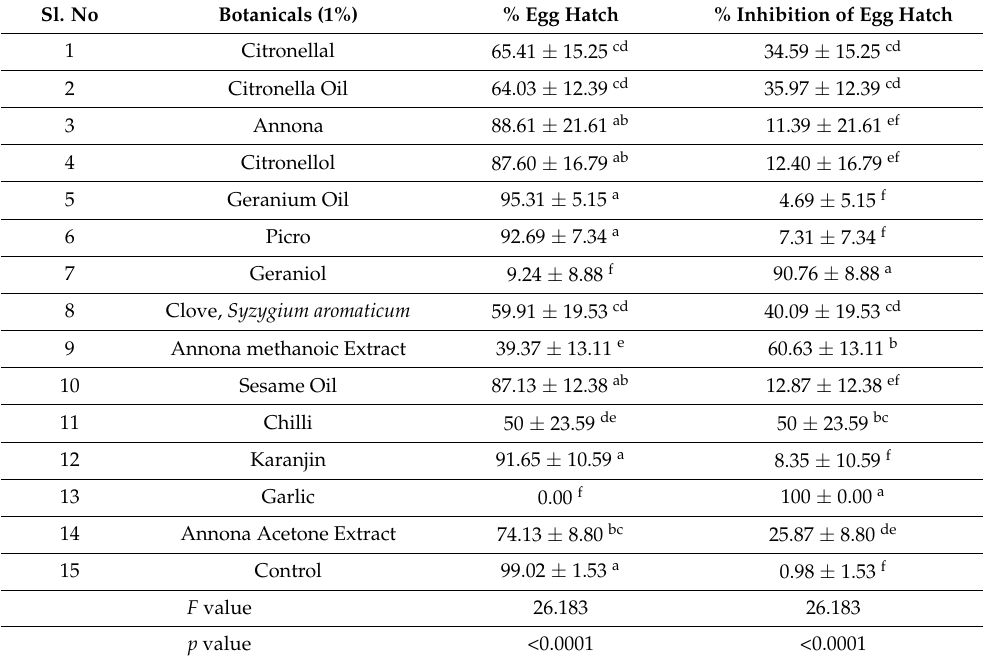
Values in table marked with different letters differ significantly; p < 0.05, Duncan’s multiple range